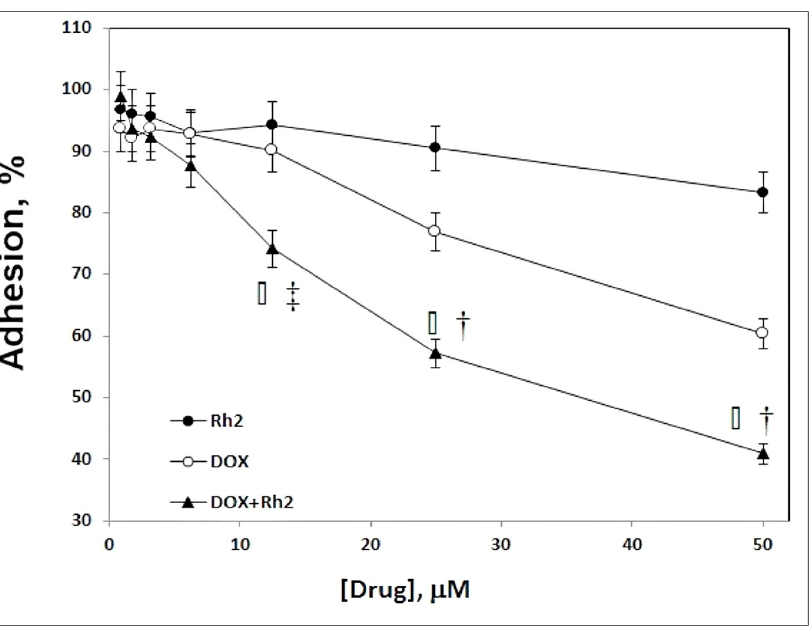
Figure 6. Effect of DOX + Rh2 co-treatment on adenocarcinoma cell adhesion. Evaluation of primary Ehrlich adenocarcinoma cell attachment in the presence of Rh2 and DOX taken individually or as a 1:1 mix upon 24 h incubation. Test performed in triplicate, cell count without treatment taken as 100%, results shown as mean ± SE. (Protocol details under Materials and Methods). □ Between-treatment ANOVA at same concentration sig, p < 0.003. † Pairwise post hoc p < 0.001, all pairs. ‡ Pairwise post hoc p < 0.001, DOX + Rh2 versus single treatment.